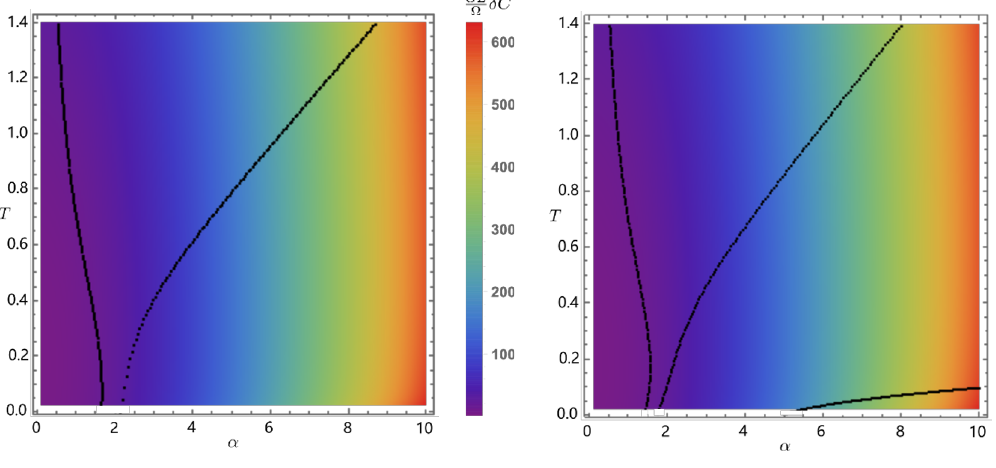
Figure 16 . Complexity of formation as a function of temperature for the Linear model with K = (cid:0) 1 = 6. Left: the charged case with (cid:26) = 1. Right: the neutral case with (cid:26) = 0. Inset: (cid:14)C (cid:14)C (cid:25) 572 : 8 (cid:0) 14 : 3 ln( T ) and for diverges as ln(1 =T ) at low temperatures. For the charged case GL (cid:10) the neutral case GL (cid:14)C (cid:25) 555 : 3 (cid:0) 19 : 2 ln( T ). For other parameters we choose (cid:11) = 10 and B = 0. (cid:10)